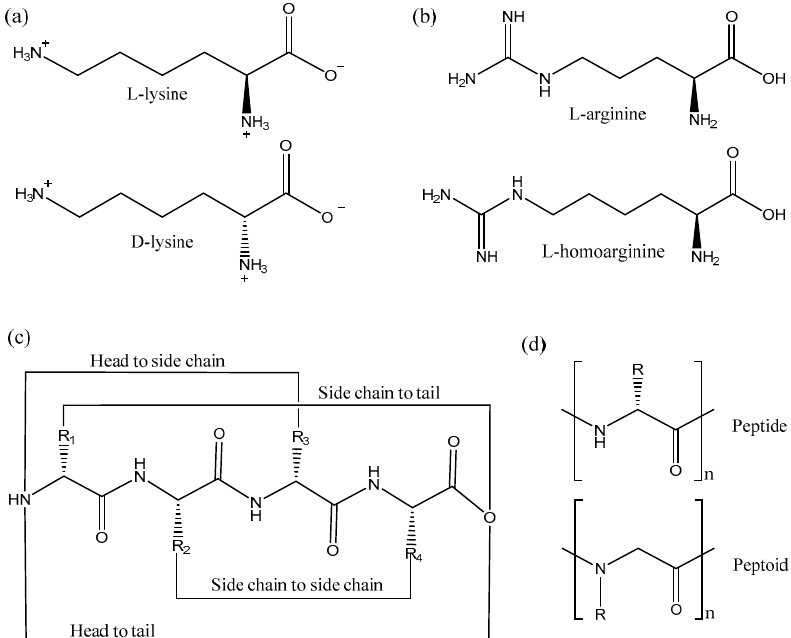
Figure 7. Chemical modifications used to improve AMP properties: ( a ) use of D -amino acids such as lysine, ( b ) use of non-natural amino acids such as L -homoarginine, ( c ) various cyclization strategies, ( d ) use of a peptoid (1-dimensional structural difference relative to a peptide shown).